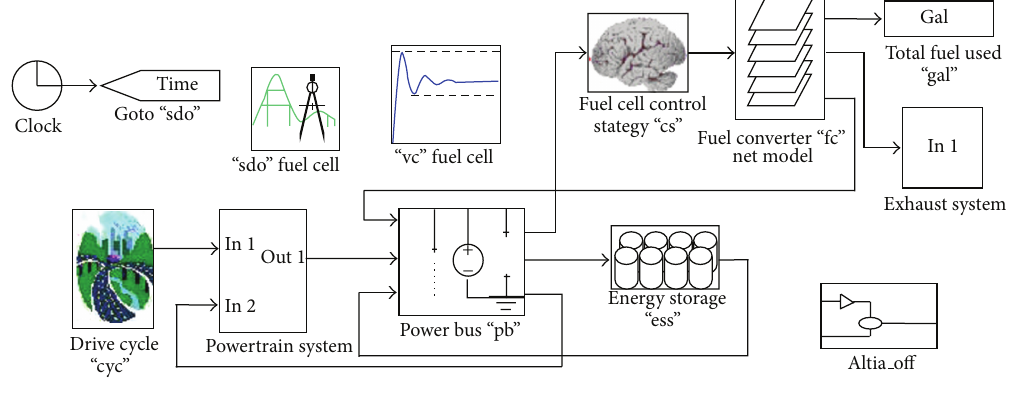
Figure 1: ADVISOR block diagram.